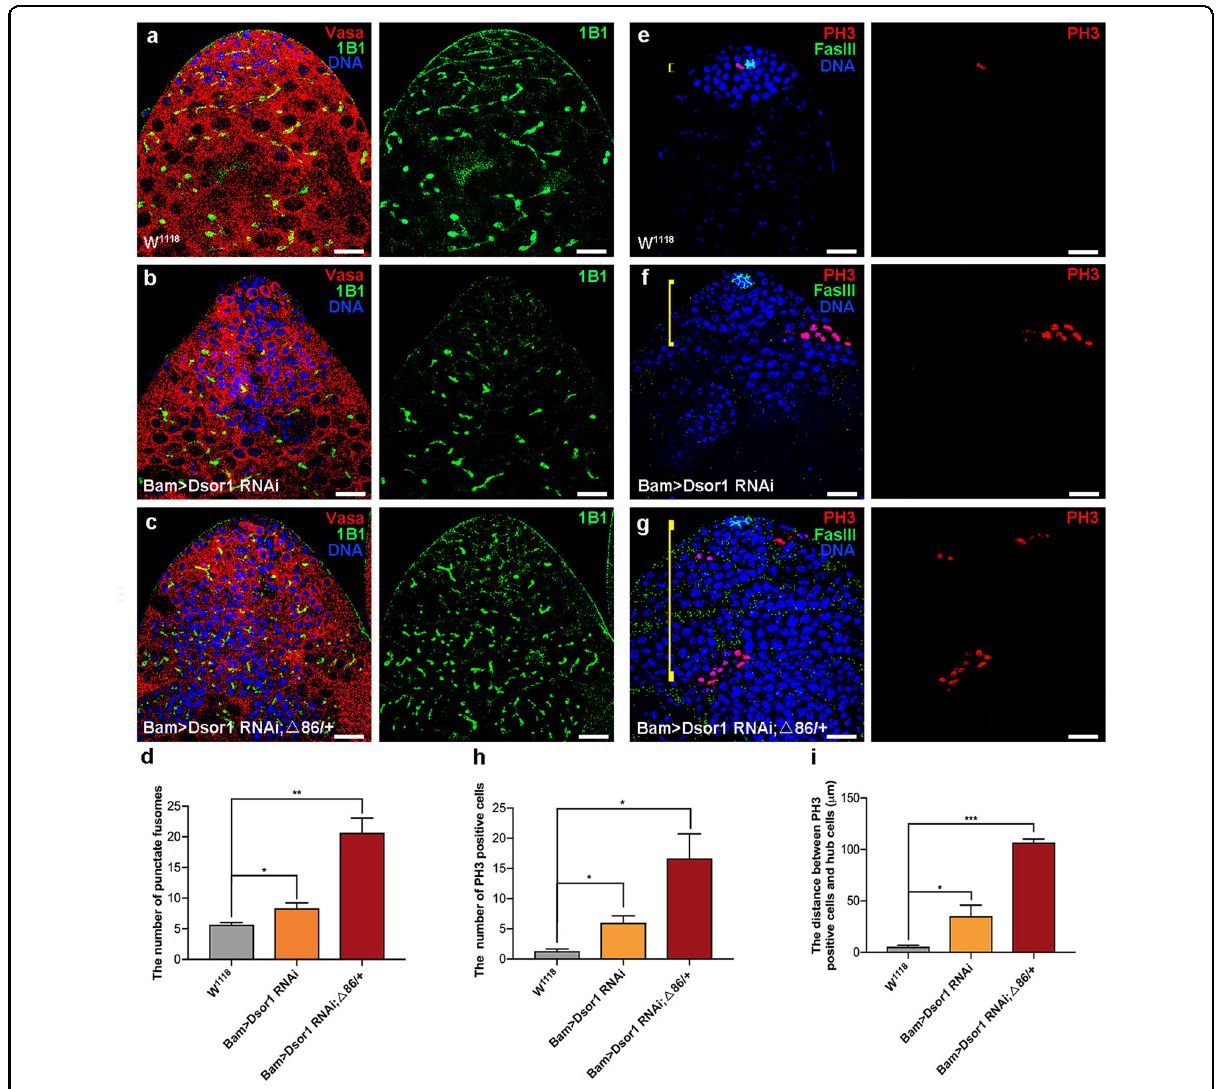
Fig. 7 Downregulation of Dsor1 in spermatogonia resulted in germline differentiation defects. a – c Immunostaining of Vasa (red) and 1B1 (green) at the apex of W 1118 , Bam> Dsor1 RNAi, and Bam> Dsor1 RNAi; Δ 86/ + testes. d The number of punctate fusomes in W 1118 ( n = 3), Bam> Dsor1 RNAi ( n = 3), and Bam> Dsor1 RNAi; Δ 86/ + ( n = 3) testes. e – g Immunostaining of PH3 (red) and FasIII (green) at the apex of W 1118 , Bam> Dsor1 RNAi, and Bam> Dsor1 RNAi; Δ 86/ + testes. Yellow lines represent the distance between PH3-positive cells and hub cells. h The number of PH3-positive cells in W 1118 ( n = 3), Bam> Dsor1 RNAi ( n = 3), and Bam> Dsor1 RNAi; Δ 86/ + ( n = 3) testes. i The distance between PH3-positive cells and hub cells in W 1118 ( n = 3), Bam> Dsor1 RNAi ( n = 3), and Bam> Dsor1 RNAi; Δ 86/ + ( n = 3) testes. DNA was stained with Hoechst (blue). * P < 0.05, ** P < 0.01, *** P < 0.001. Scale bars: 20